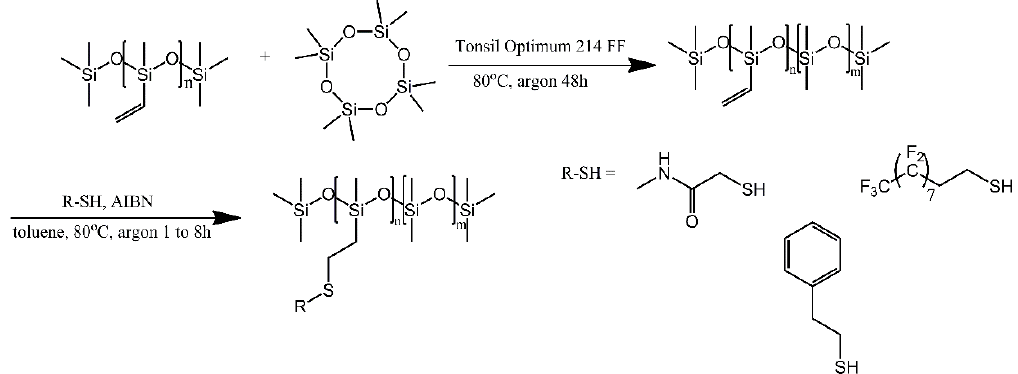
Figure 10. General scheme for the synthesis of functionalised polysiloxanes. Based on Ref. [27].